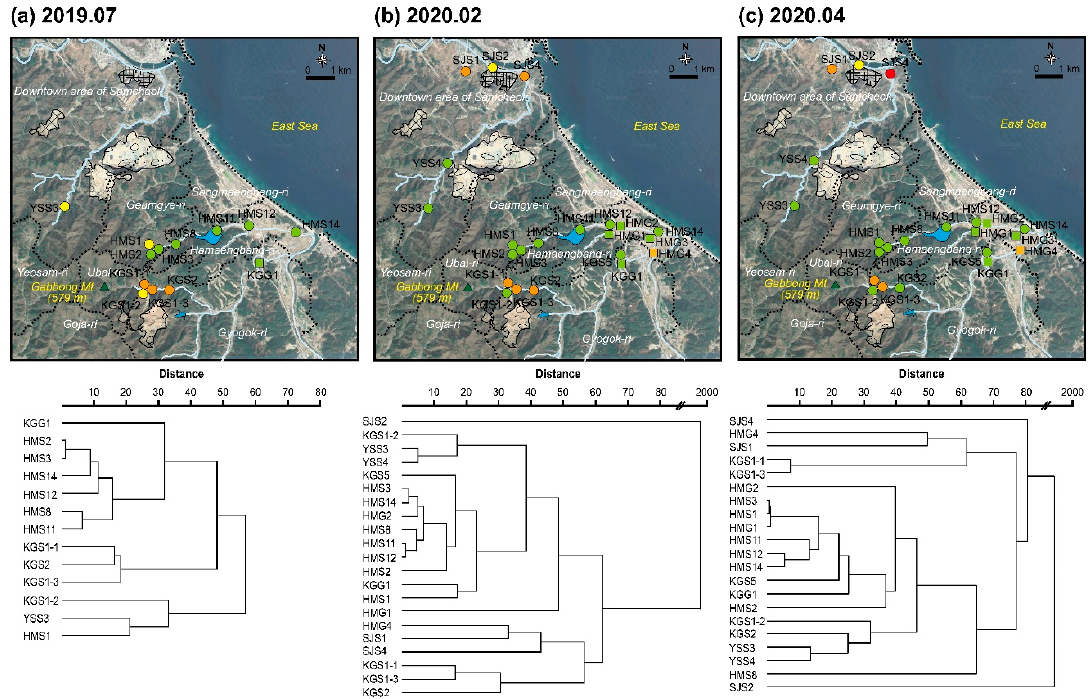
Figure 8. Cluster analysis accounting to water chemistry data (cation/anion and alkalinity) at the sampling point of the study area by research period: ( a ) July 2019, ( b ) February 2020, and ( c ) April 2020. Identical colors of points on the map denote the same cluster. The software used this chemistry data cluster analysis (algorithm: Paired group (UPGMA), similarity index: Euclidean) is PAST3.